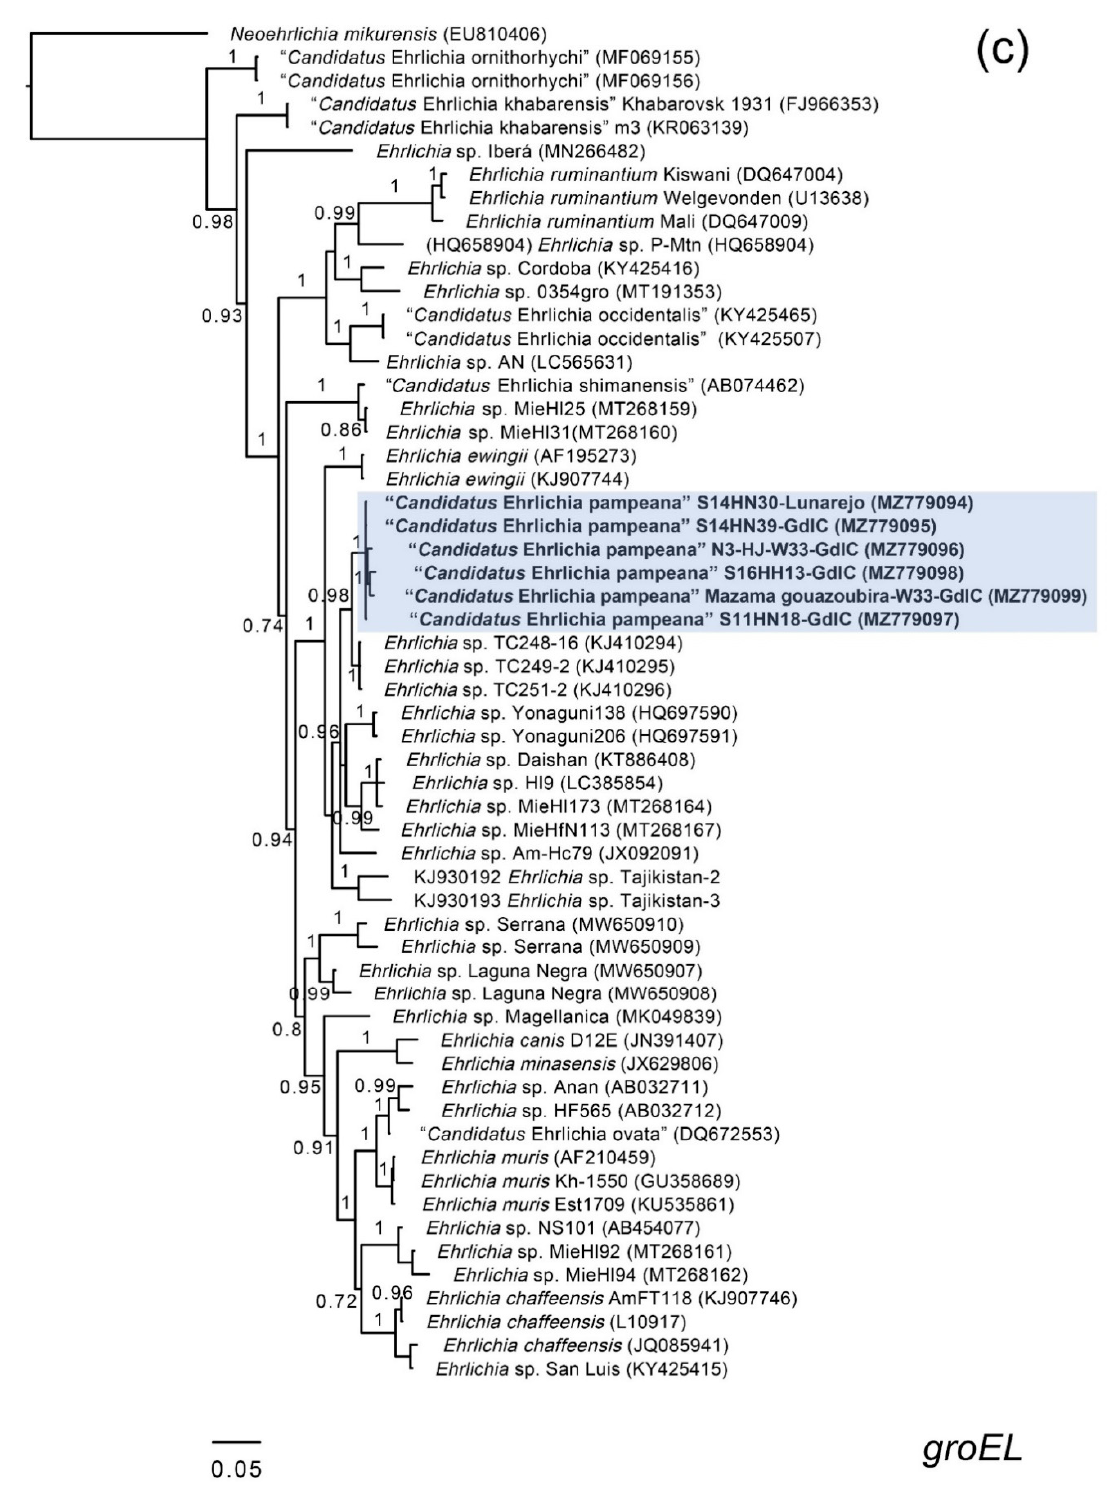
Figure 1. Bayesian phylogenetic analyses inferred for partial fragments of the genes ( a ) 16S rRNA, ( b ) dsb, and ( c ) groEL . Bayesian posterior probabilities are indicated upon each branch. The positions of “ Candidatus Ehrlichia pampeana” are highlighted with blue. Scale bar indicates the number of substitutions per nucleotide position. GenBank accession numbers are in brackets.